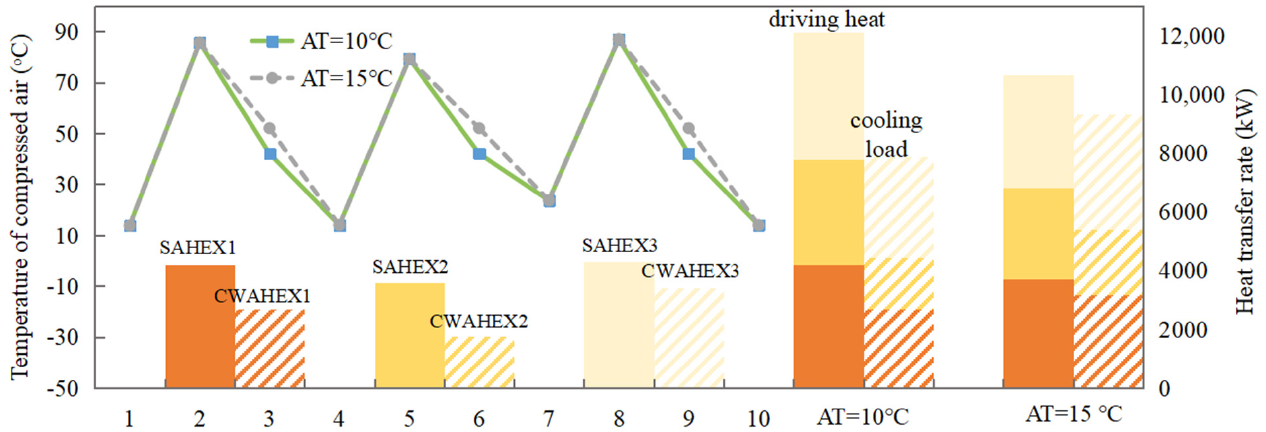
Figure 7. Cooling load allocation of SAHEXs and